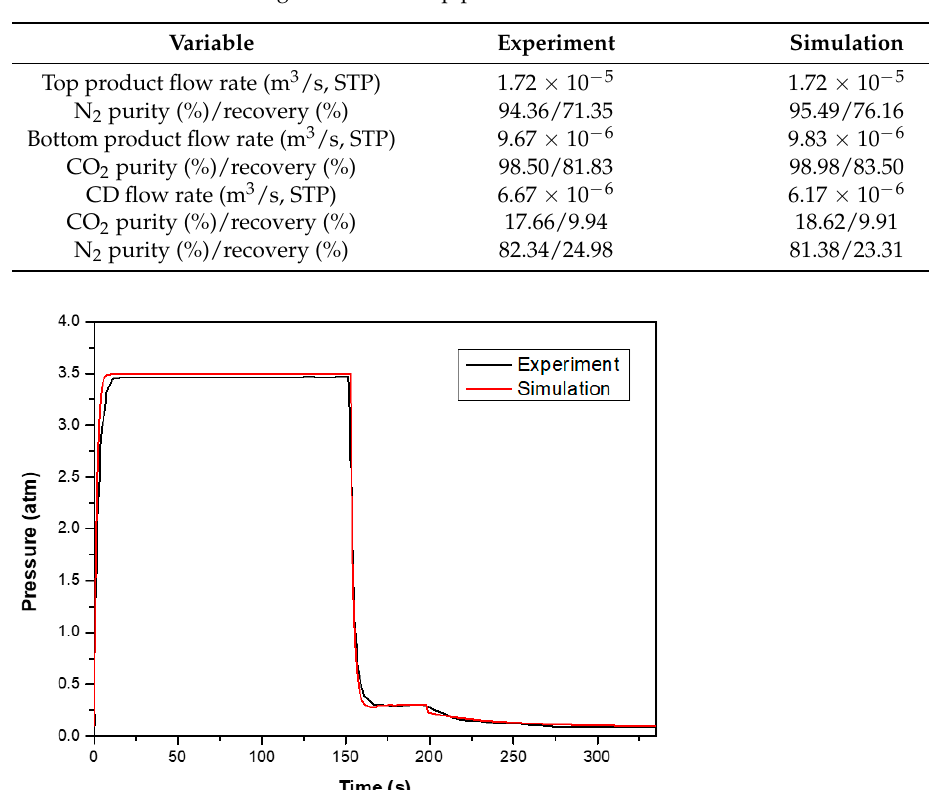
Table 11. Results of the single-bed three-step process.